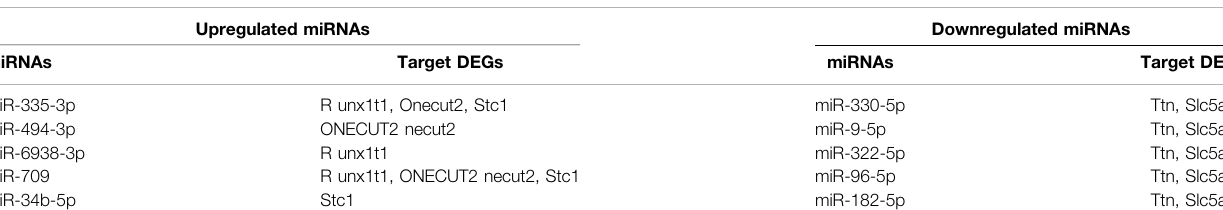
TABLE 2 | The hub miRNAs and genes.